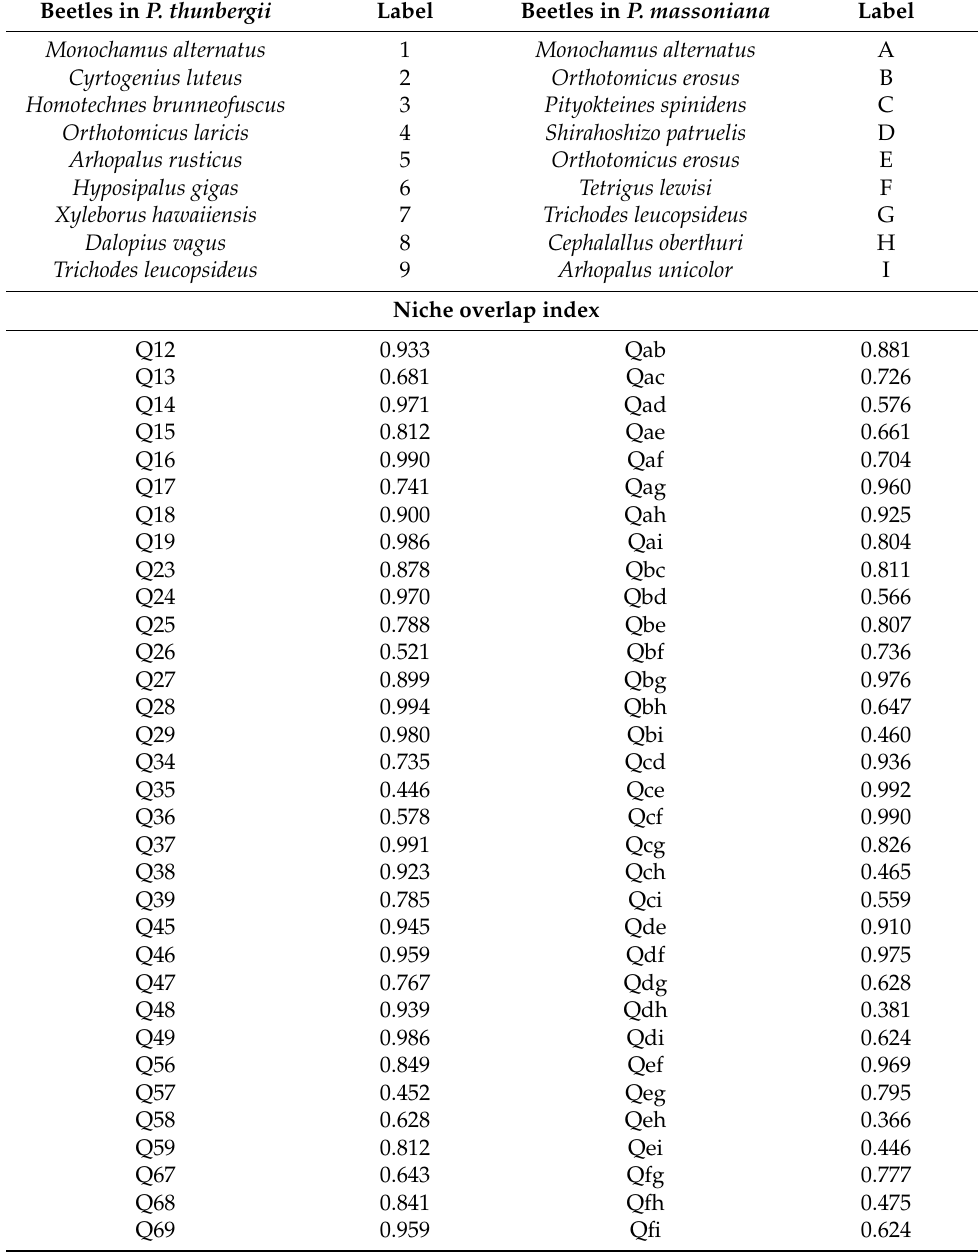
Table A3. Niche overlap of xylophagous beetles in the infected pine trees. Beetles in P.